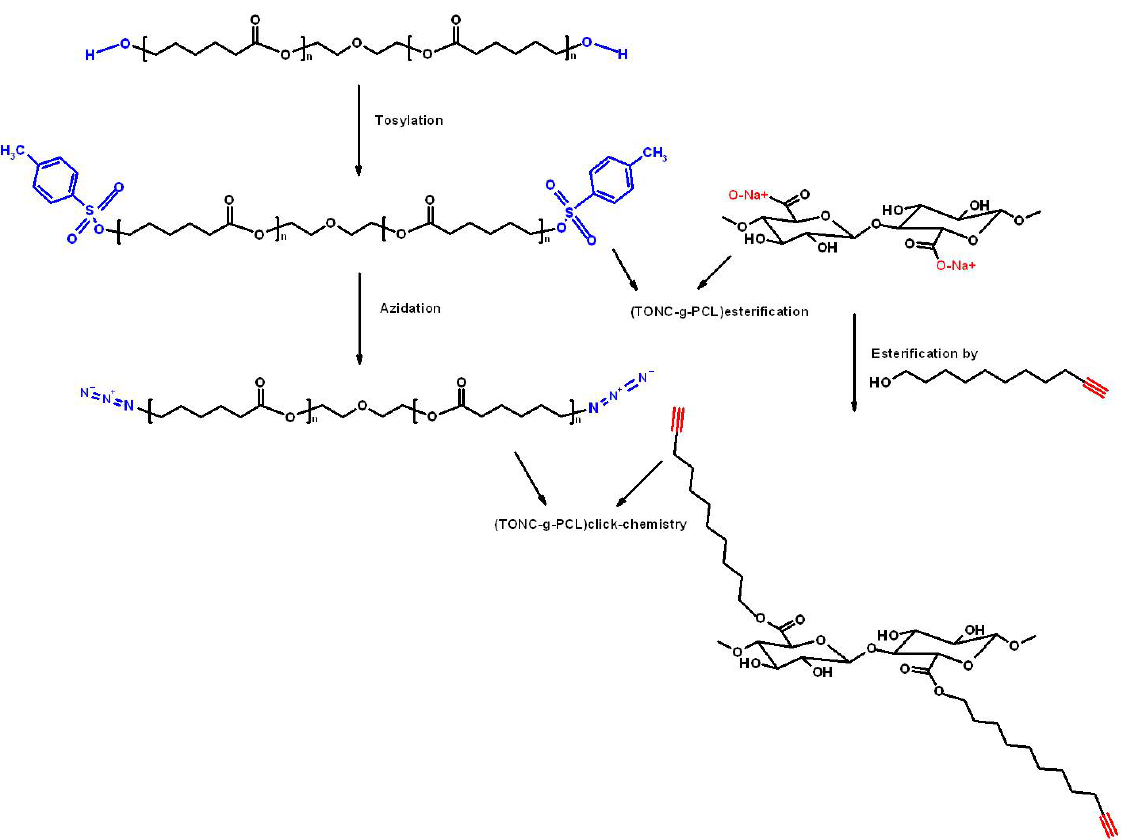
Figure 12. Strategies adopted for the grafting of polycaprolactone-diol onto TONC by direct esterification and click